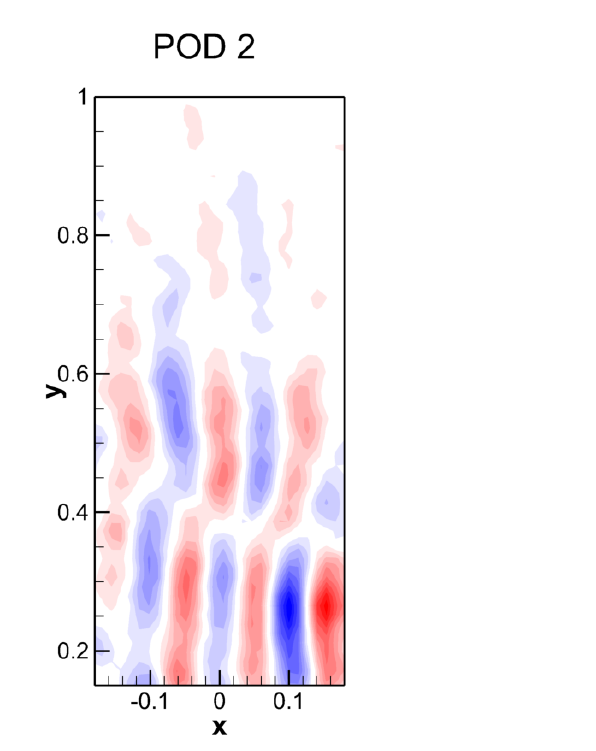
Fig. 17. Vorticity POD mode No. 2, 1.03 TE.